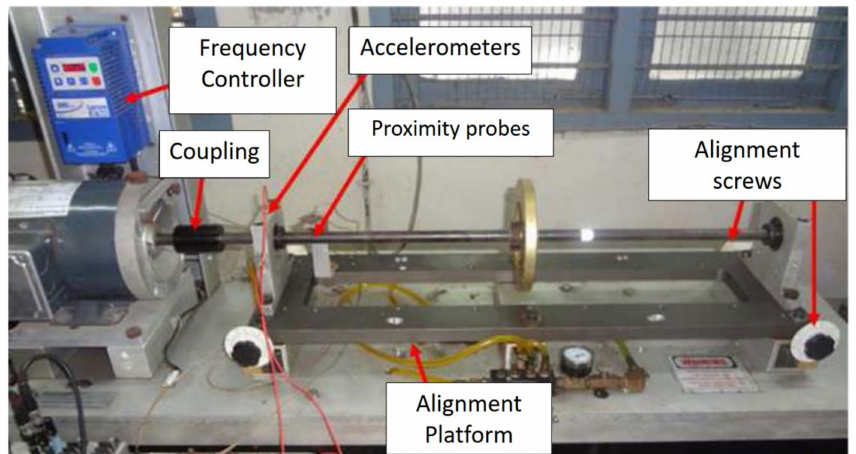
Figure 16. Experimental setup for nonlinear damping identification in rotors [117].